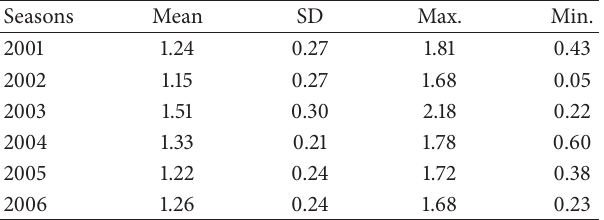
Table 2: The average, standard deviation, maximum and minimum values of CWP in all 80 counties from 2001 to 2006 (kg m − 3